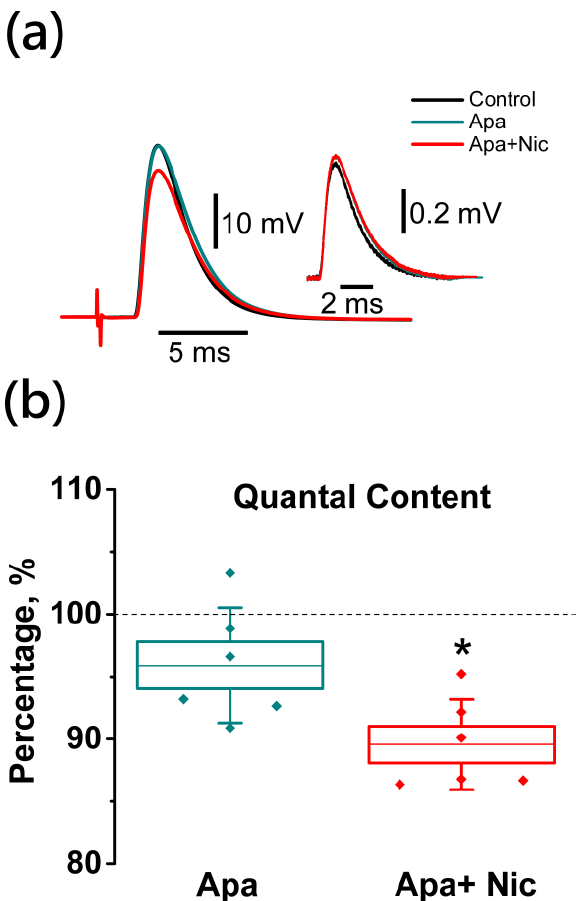
Figure 8. Nicotine-induced decrease in ACh release (quantal content, QC) is observed in the presence of apamin (Apa), the blocker of small conductance Ca 2+ -activated K + channels. Panel on the top ( a ) is representative traces of EPP and mEPP (50 signals averaged) from individual experiments with apamin application (100 nM) and with nicotine (Nic, 10 μM) application after pretreatment with apamin; ( b ) Mean ± SEM and SD of QC, expressed as a percentage of control or value after apamin ( n = 6), apamin + Nic ( n = 6). Asterisks (*) indicate significant effects ( p < 0.05, one-way repeated ANOVA test with Tukey’s post-hoc comparison).